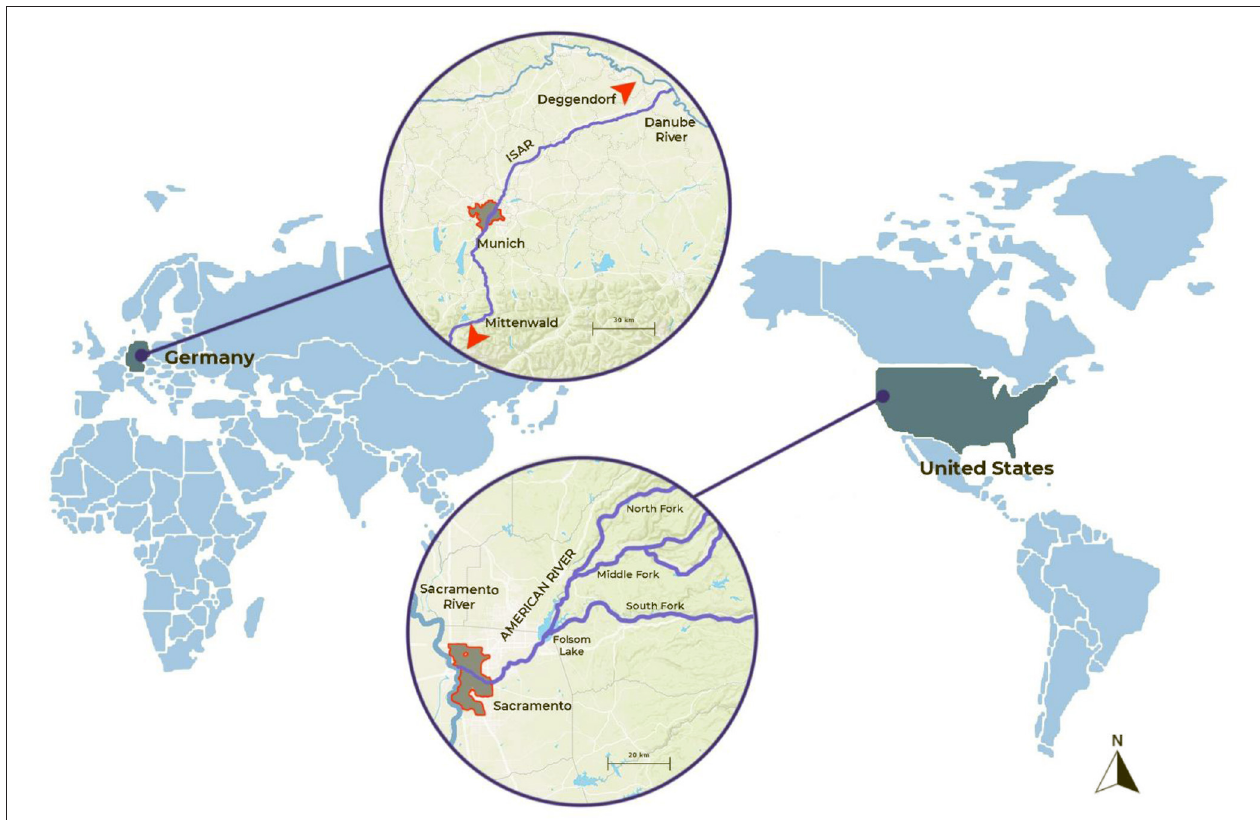
FIGURE 2 | Location of the case study sites.